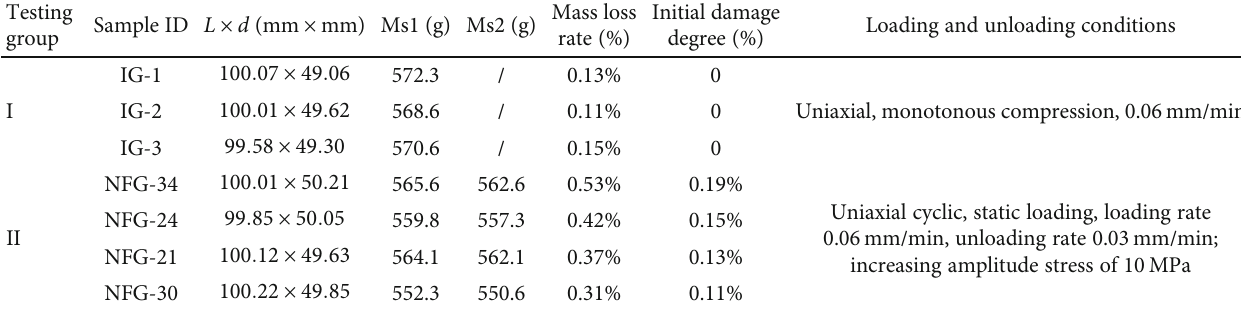
Table 1: Testing scheme for the naturally fractured granite under uniaxial cyclic conditions.